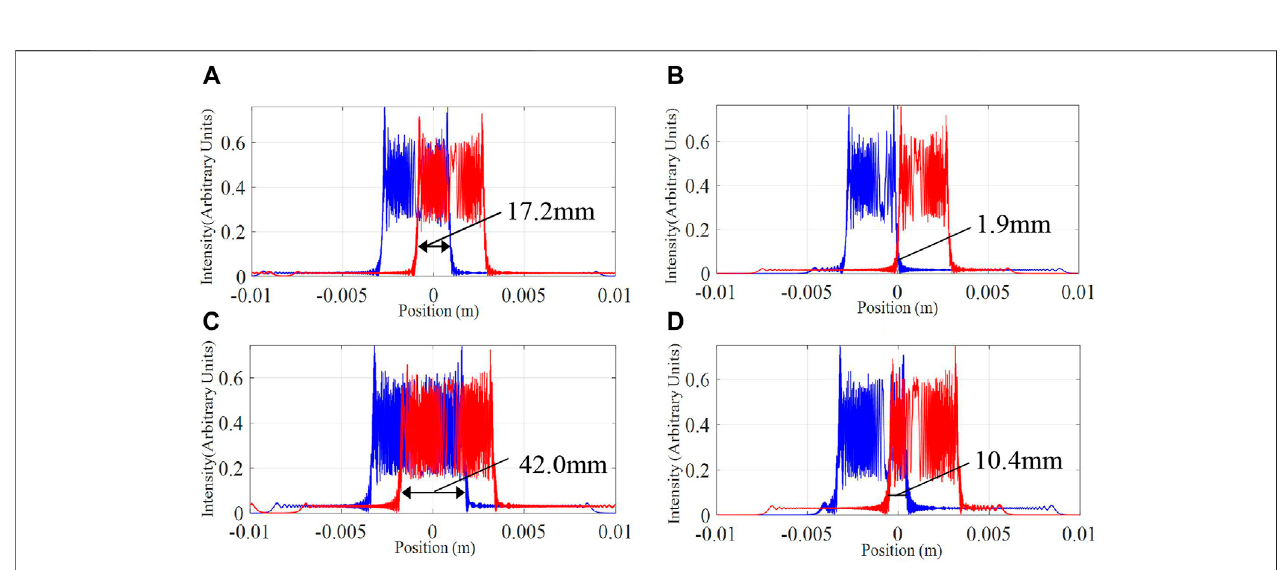
FIGURE 7 | Light intensity distribution of the leftmost and rightmost image points of (A) the proposed method at R (cid:1) 500 mm, (B) the traditional method at R (cid:1) 500 mm, (C) the proposed method at R (cid:1) 800 mm and (D) the traditional method at R (cid:1) 800 mm.